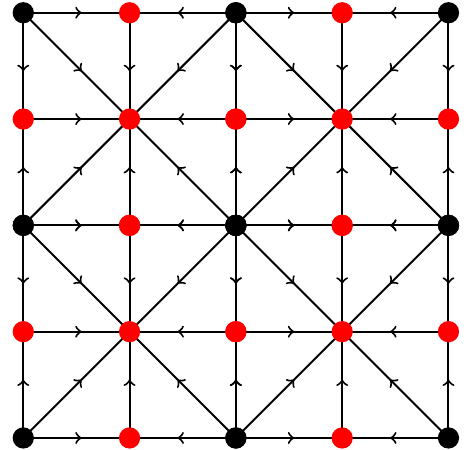
FIG. 17. A p 4 m -invariant triangulation and branching structure. The black dots are the vertices of the original p 4 m -invariant cellulation (the simple square lattice), and the red dots are the verticesthathadtobeadded(throughthebarycentricsubdivision)to get a p 4 m -invariant triangulation and branching